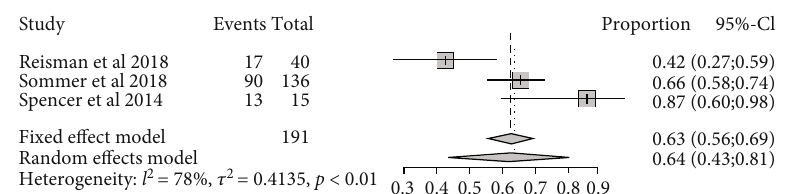
Figure 2: Forest plot of the P2Y12 platelet inhibitor for migraine headaches responder rate in migraine with or without PFO.